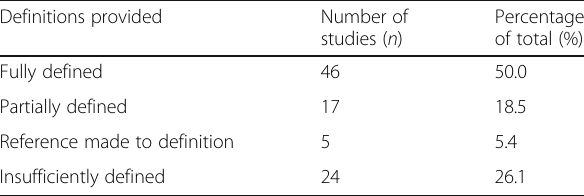
Table 4 A summary of the definitions provided for all studies Definitions